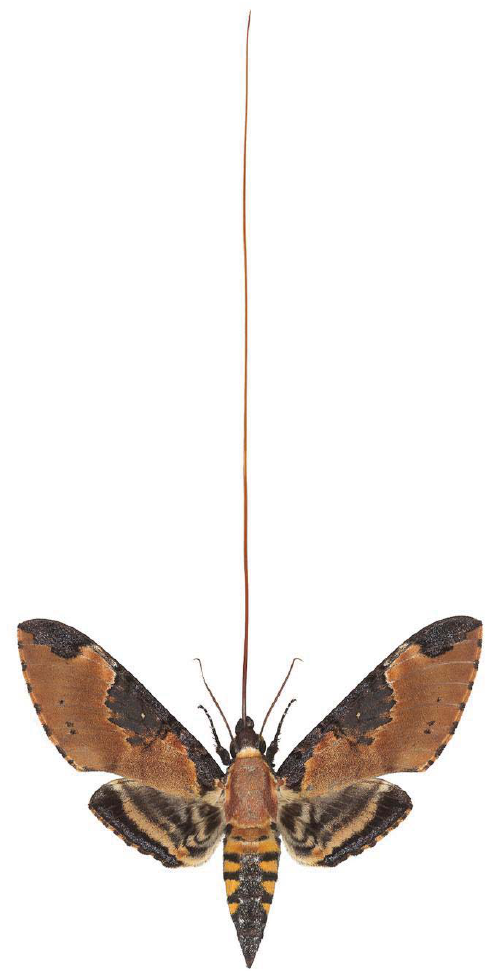
Figure 10. An extremely long-tongued hawk-moth, Manduca ochus from Sonora,